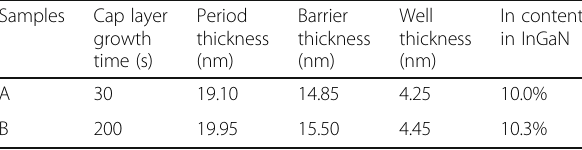
Table 1 Structural parameters of InGaN/GaN MQWs of samples A and B determined by HRXRD